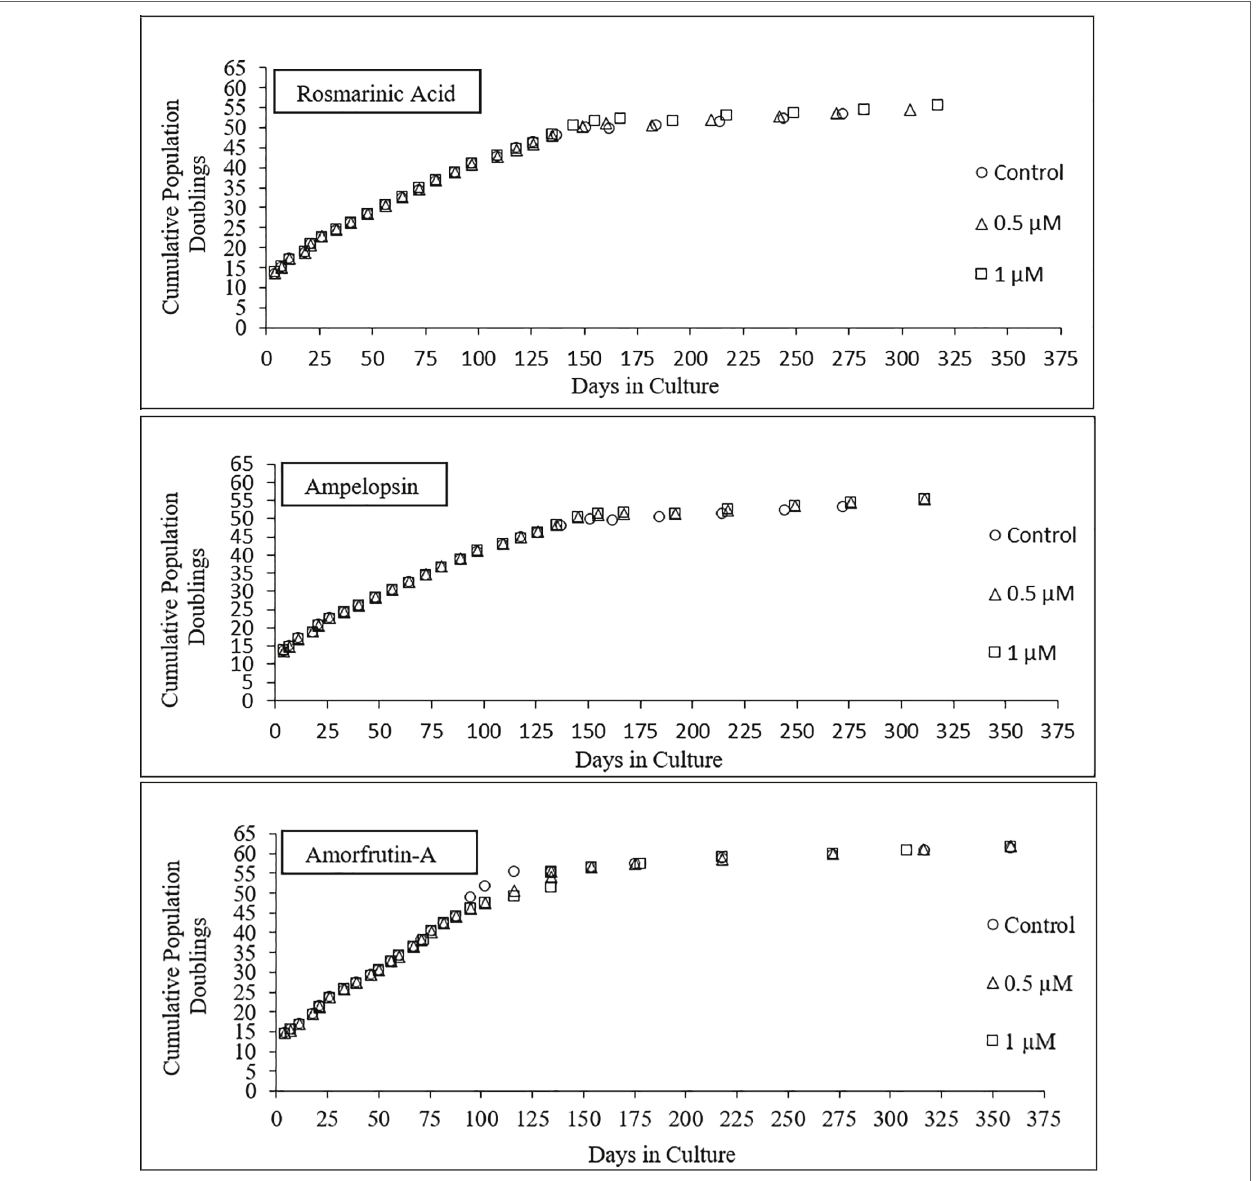
FIGURE 4 | Longevity curves of PCS cells serially passaged from PDL13 (p13) onward until the end of their replicative lifespan in vitro , in the presence or absence of two doses of individual test